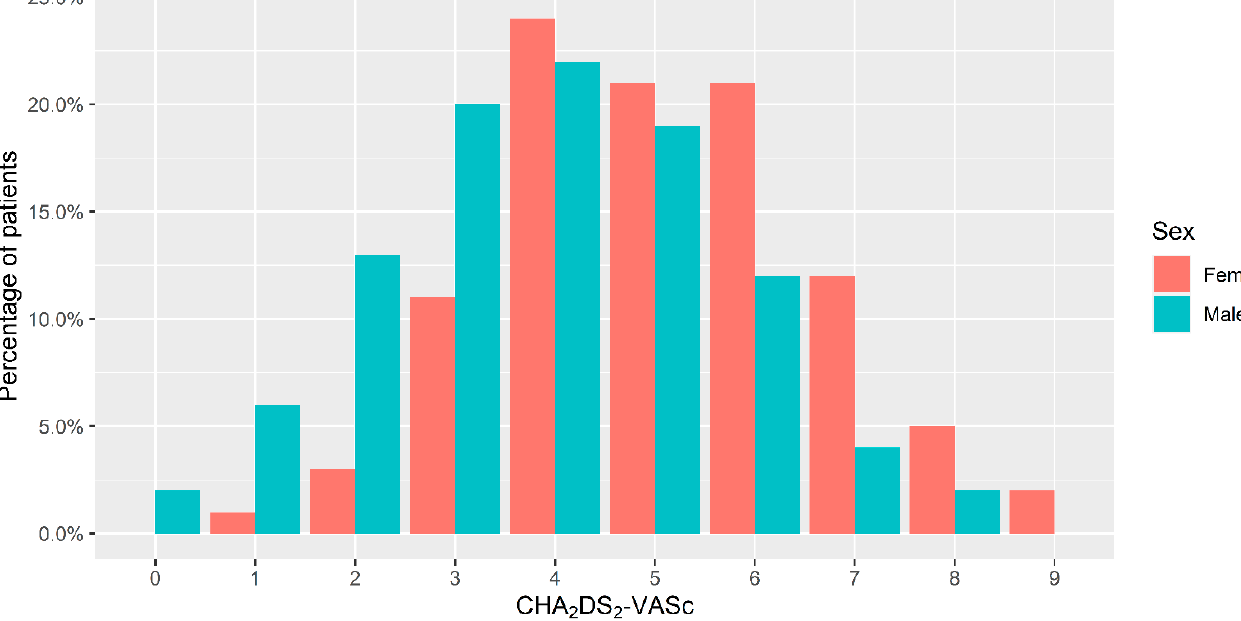
Figure 2. CHA 2 DS 2 -VASc score patient distribution based on sex.